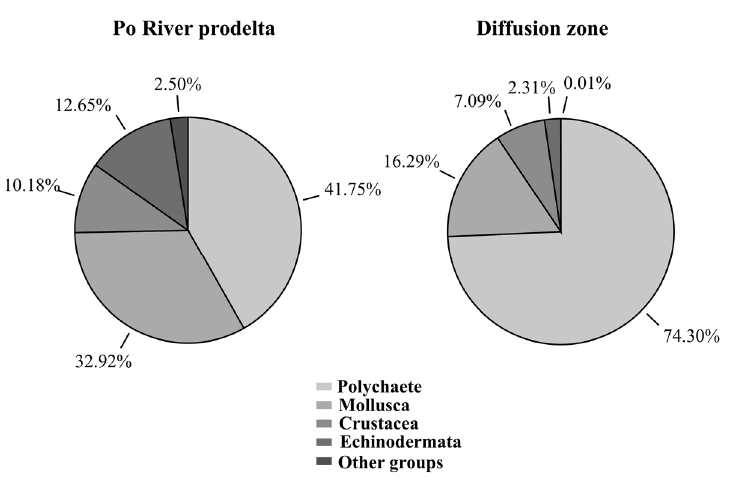
Figure 2. Pie charts representing the proportion of polychaetes, mollusks, crustaceans, echinodermata, and other groups for both study areas. The values close to the pie charts indicate total abundance.